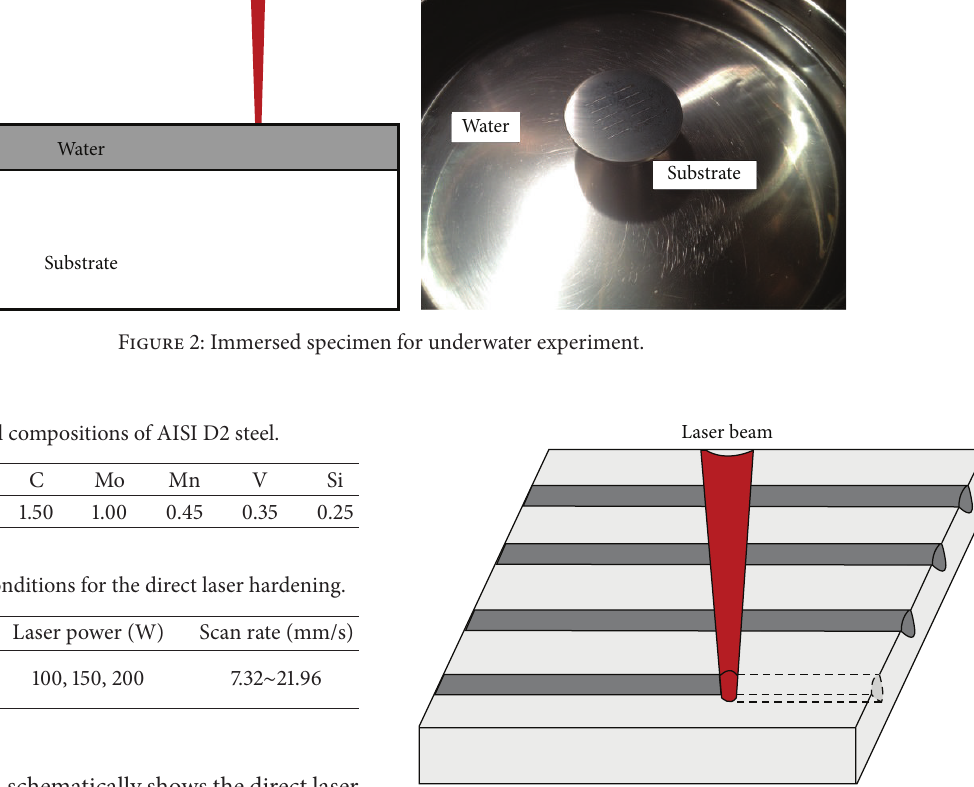
Figure 3: Schematic drawing of single-track laser melting experi-